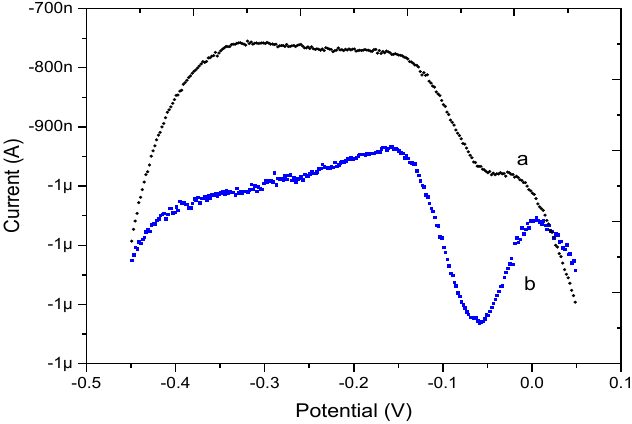
Figure 4. Differential pulse stripping voltammetry (DPSV) responses of bare Au (curve a) and PPy/MWCNT/Au (curve b) in the presence of 10 μg·L − 1 Pb 2+ .